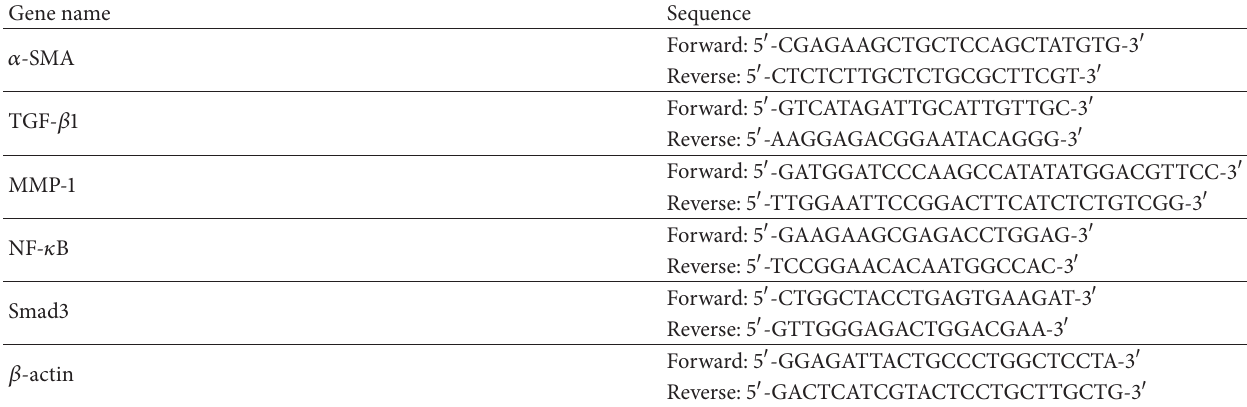
Table 1: PCR primers used in this